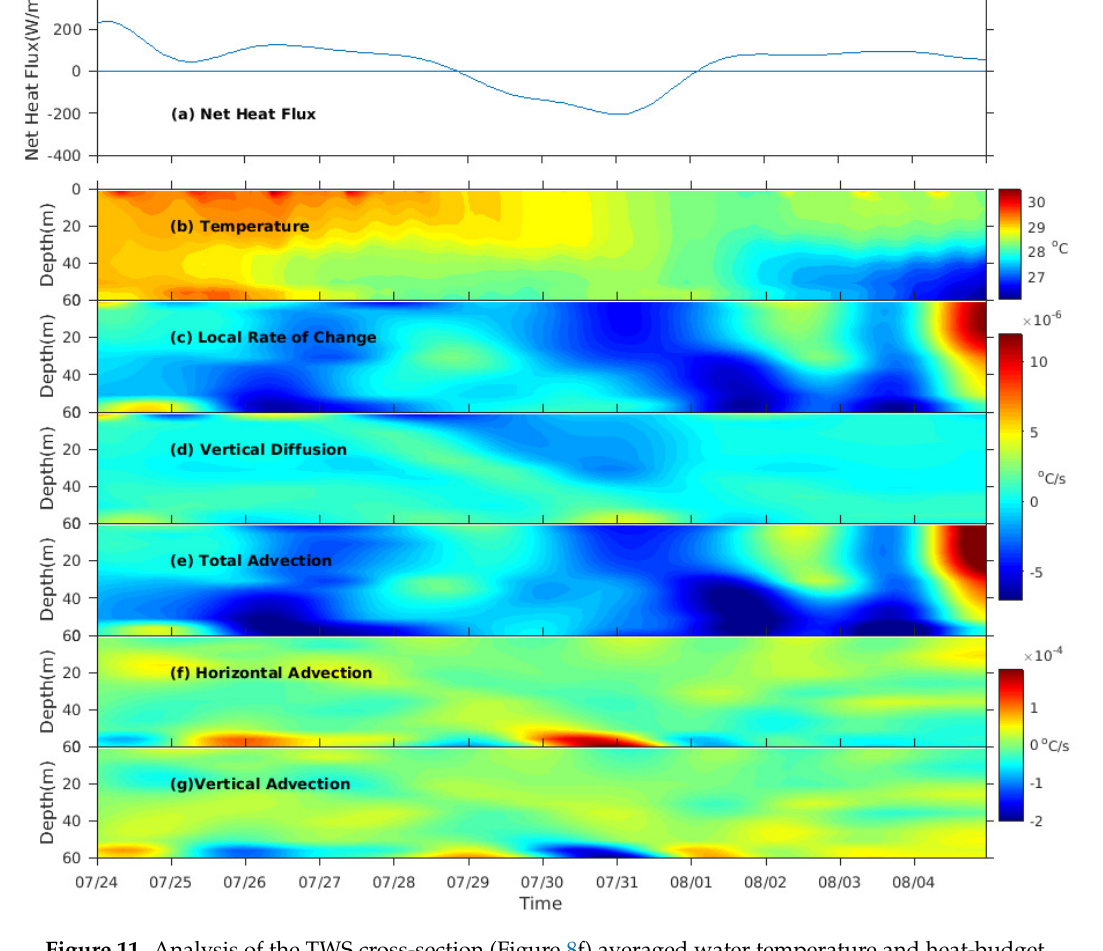
Figure 11. Analysis of the TWS cross-section (Figure 8f) averaged water temperature and heat-budget term evolution with time or time and depth: ( a ) net surface heat flux, ( b ) water temperature, ( c ) local rate of change, ( d ) vertical diffusion, ( e ) total advection (horizontal + vertical), ( f ) horizontal advection, and ( g ) vertical advection. Horizontal and vertical terms are an order of magnitude greater than other budget terms (local rate of change, vertical diffusion, total advection), hence a different colour scale is used.